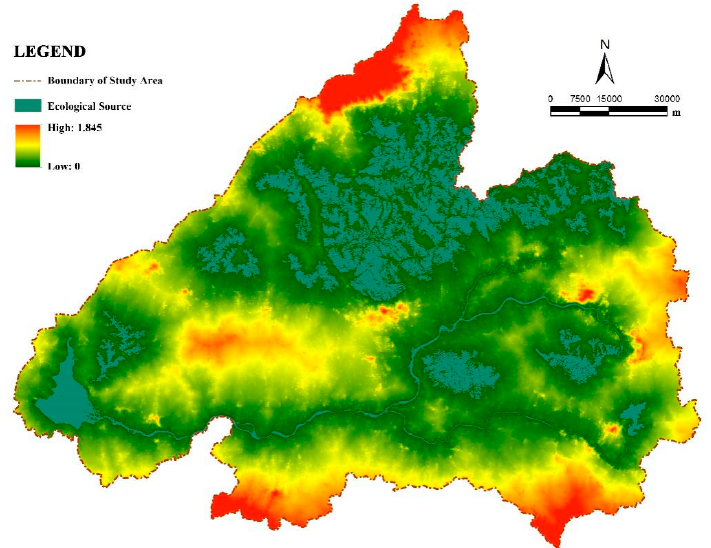
Figure 6. Construction of ecological resistance surface in Taishan area.